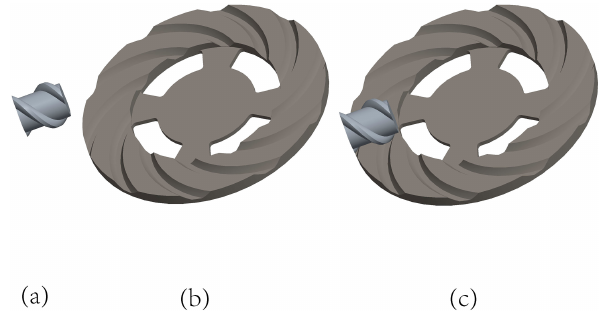
Figure 9. 3-D solid model 2. (a) Driving gear 2; (b) driven gear 2; (c) meshing simulation.